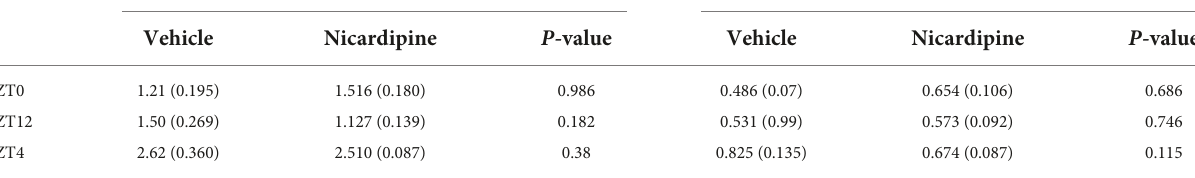
TABLE 1 Means of NREM delta power decay peaks and ends during NREM sleep episodes.